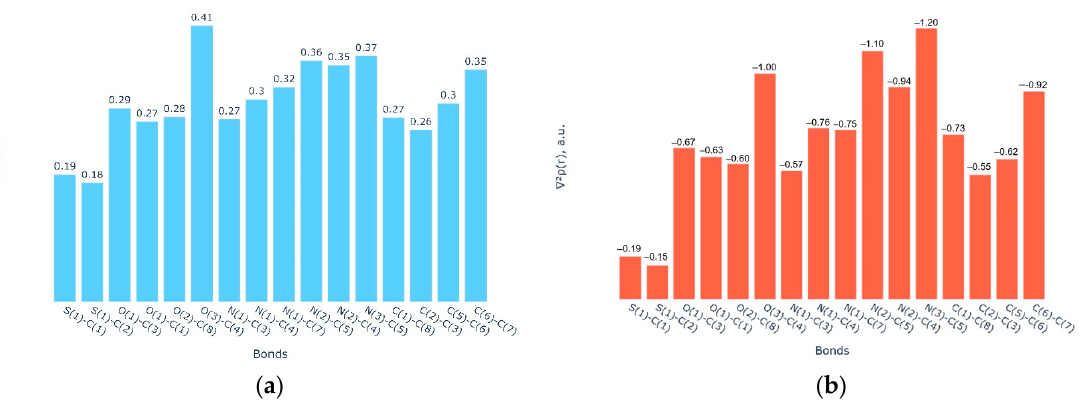
Figure 4. ( a ) The values of electron density and ( b ) its Laplacian in bcps in 3TC (atomic units).